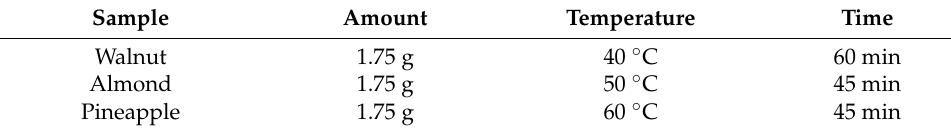
Table 3. List of optimal sampling conditions as resulted by DoE for VOCs